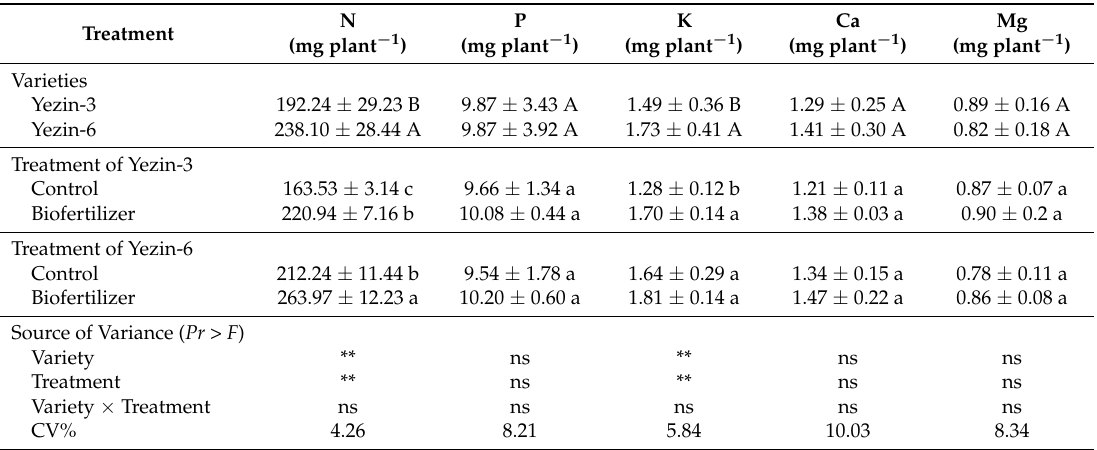
Table 8. Effect of biofertilizer on N, P, K, Ca and Mg uptakes of Yezin-3 and Yezin-6 soybean varieties at R8 stage.